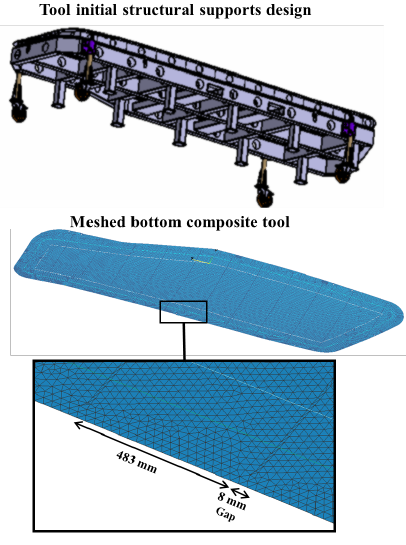
Figure 9: An illustration of the gap between the heating elements due to structural